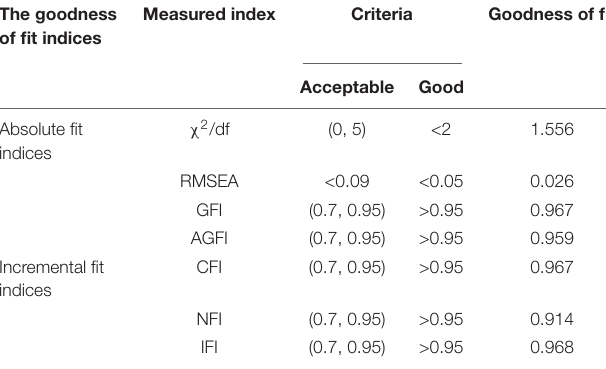
TABLE 4 | The goodness of fit